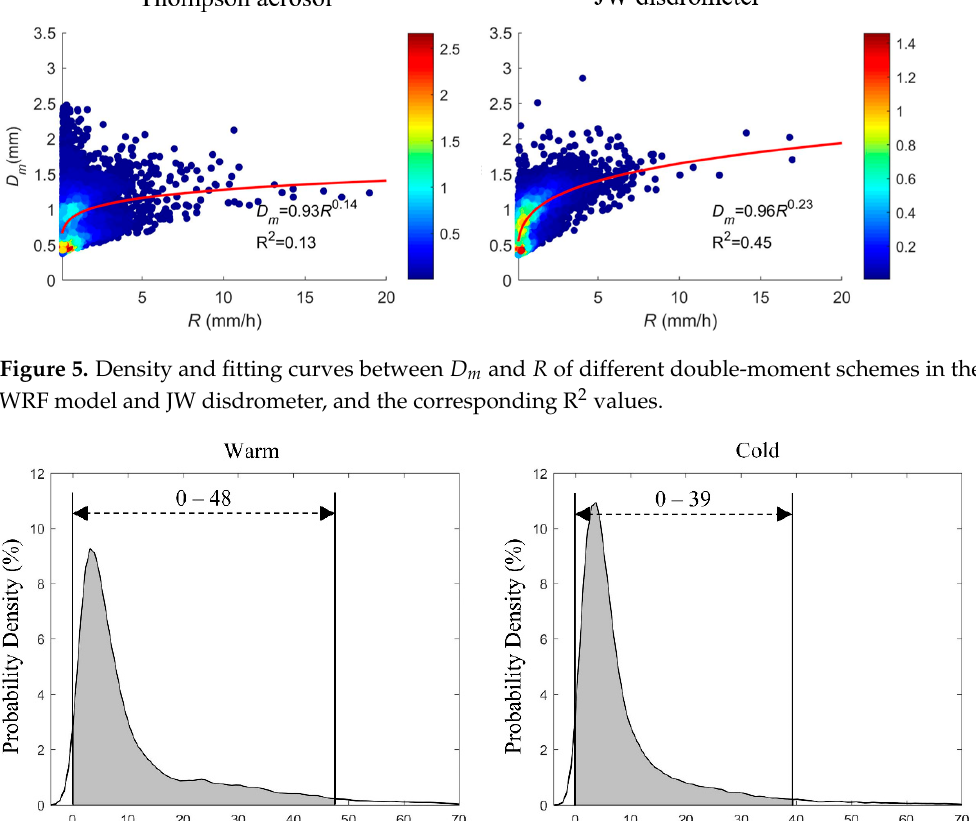
Figure 5. Density and fitting curves between 𝐷 (cid:3040) and 𝑅 of different double-moment schemes in the WRF model and JW disdrometer, and the corresponding R 2 values.